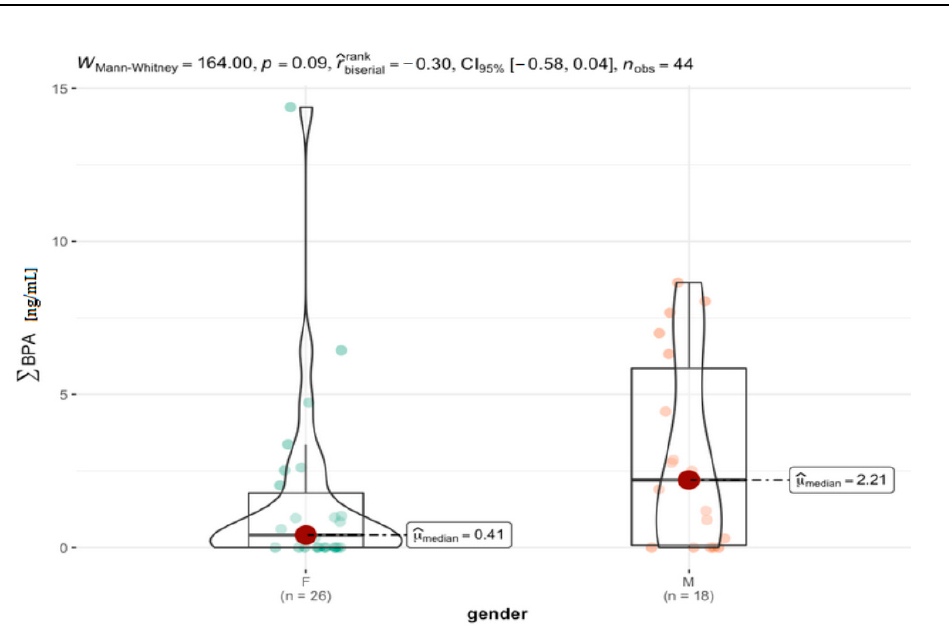
Figure 6. Statistical significance of differences in total BPs content in AH samples of females (F) and males (M).